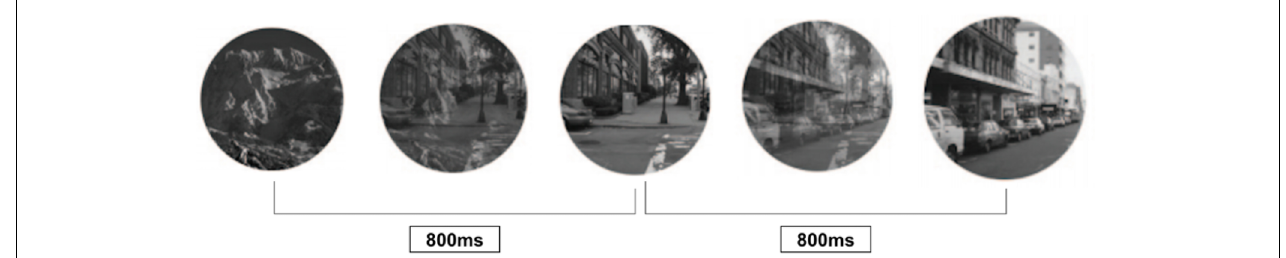
FIGURE 1 | Illustration of gradCPT procedures, adapted from Fortenbaugh et al.